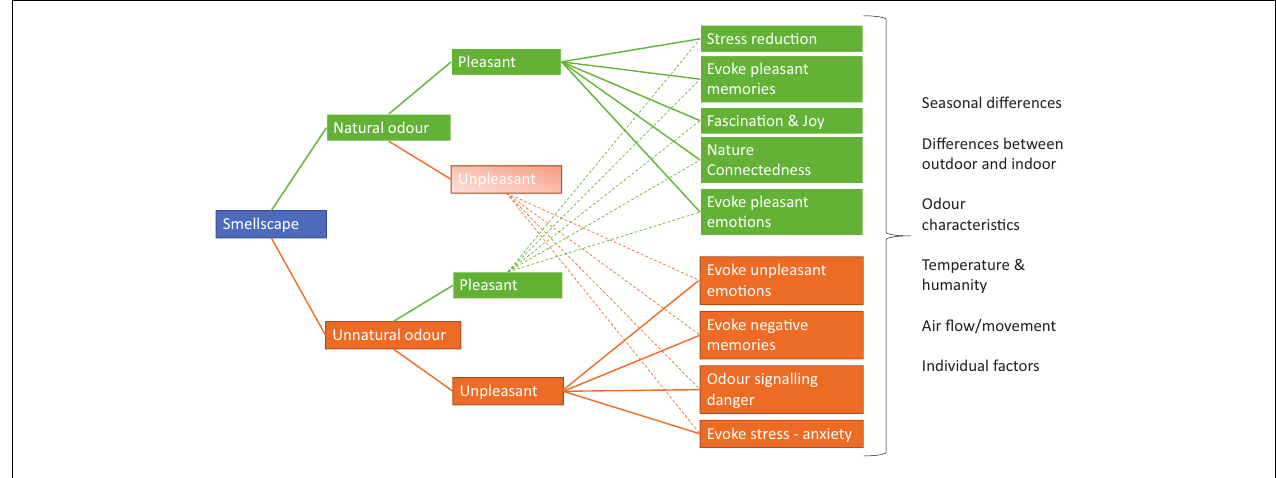
FIGURE 3 | Illustration of olfactory mechanism identified as natural and unnatural